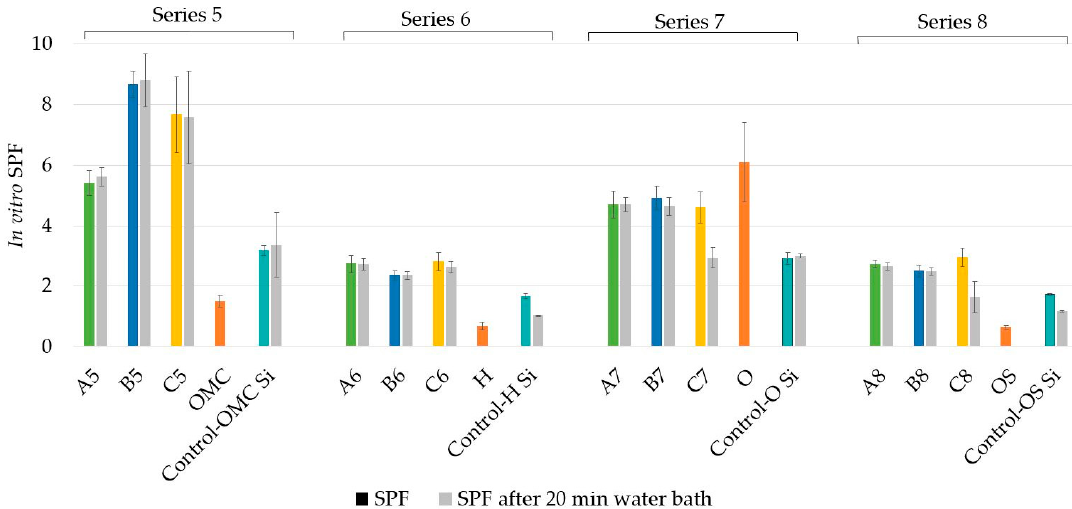
Figure 3. In vitro sun protection factor (SPF) of Series 5–8 sunscreens compared to that of the individual ultraviolet (UV) filters and control formulas. OMC: OM cinnamate; H: homosalate; O: octocrylene; OS: octyl salicylate; Si: silicone resin; A: alkenones; B: beeswax; C: cetyl alcohol.